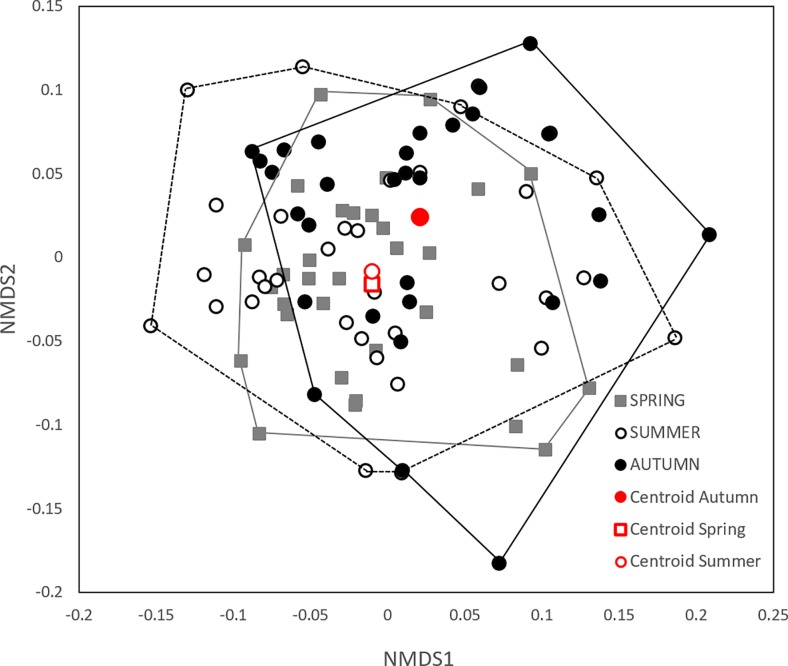
Nonmetric multidimensional scaling ordination diagram of sites based on Bray–Curtis similarity in diatom composition in spring, summer and autumn.Average within group dissimilarity spring: 0.77 (grey squares); summer: 0.83 (open circles); autumn: 0.81 (black circles). The results of the statistical tests of community structure are visible in the graph: the groups differed in their relative position (centroids–PERMANOVA test) and not in the dispersion of the sampling points. (Stress = 0.25).